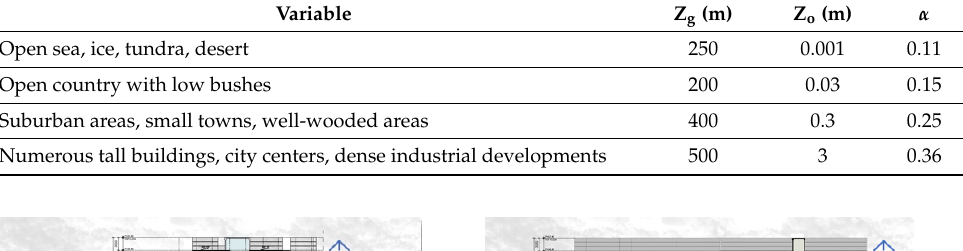
Figure 4. Experiment floors and starting point of measurements. Table 1. Values for the roughness length [39].